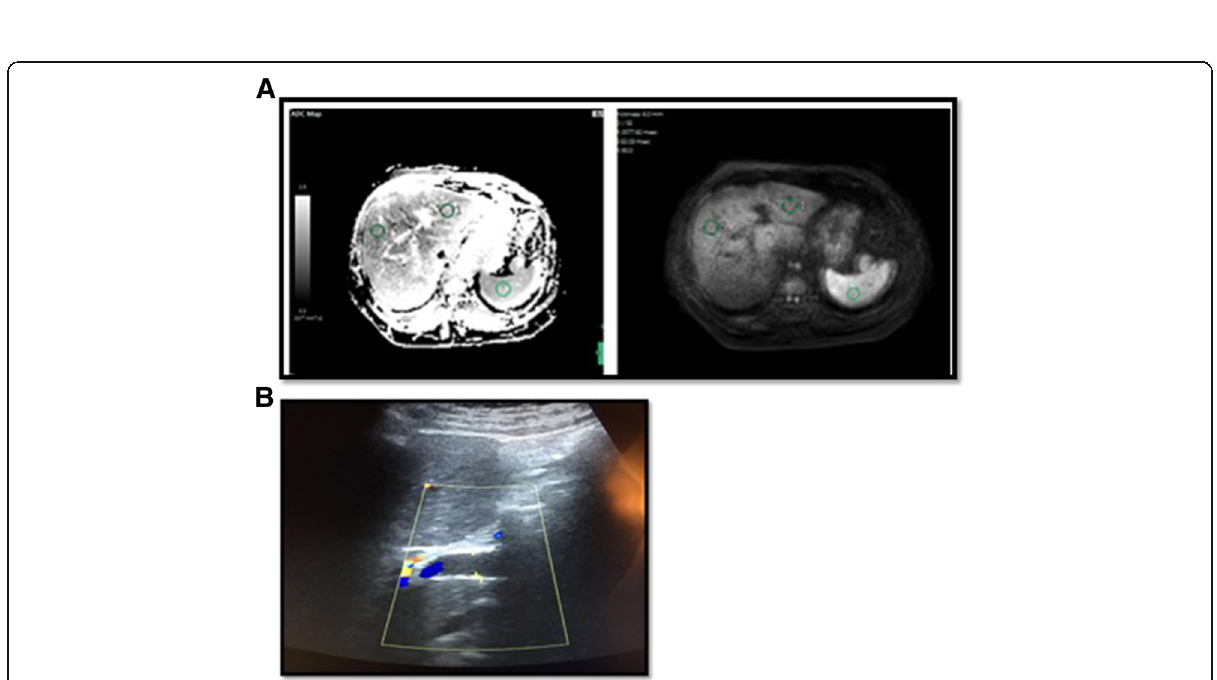
Fig. 6 a - 53 years old HCV positive male patient underwent Fibroscan with 6.3kPa which was classified as F1 stage. (F1=5-7 kPa), his Diffusion study: reveals mildly enlarged liver with no focal lesions. The spleen was of average size with no focal lesions. ( a )- ADC map, and ( b ) - DWI at b = 800- reveals liver mean ADC = 2.4 × 10 − 3 mm2/s, and spleen mean ADC = 1.7× 10 − 3 mm2/s so normalized ADC= 1.429(F1 nADC cut off =1.44). b - His ultrasound study reveals mild hepatomegaly (16.5 cm) with no cirrhotic features or focal lesions. ( c )-There was periportal fibrosis that can explain the low normalized ADC value as by further researches there might be subtypes in one